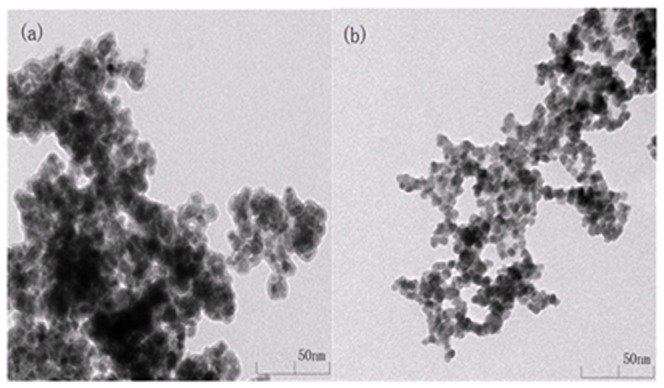
TEM images of magnetic Fe3O4 nanoparticles (a) and CM-α-CD-Fe3O4 nanoparticles (b).